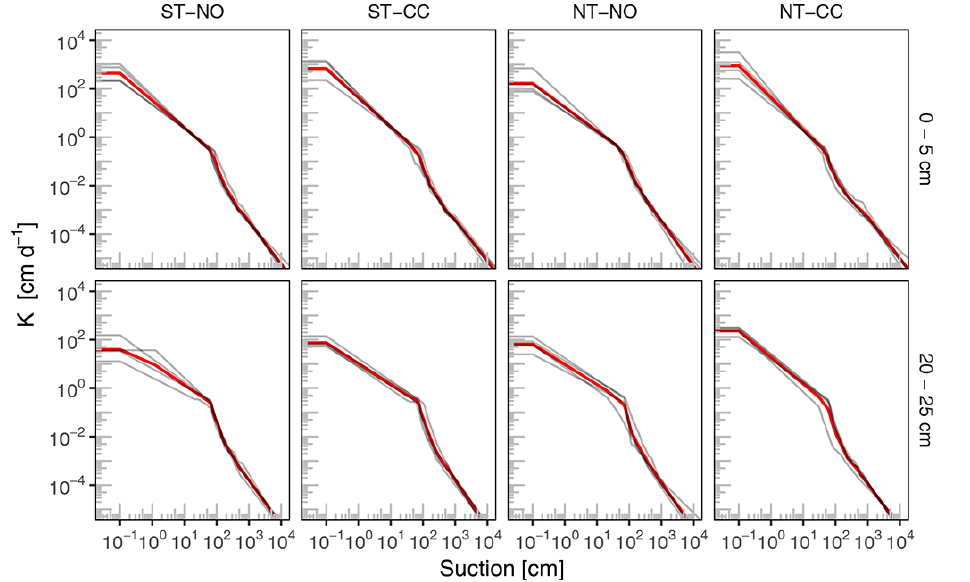
Figure A1. Hydraulic conductivity functions of top and subsurface layers by treatment. Gray curves are individual soil core measurements, and thick red curves are the treatment